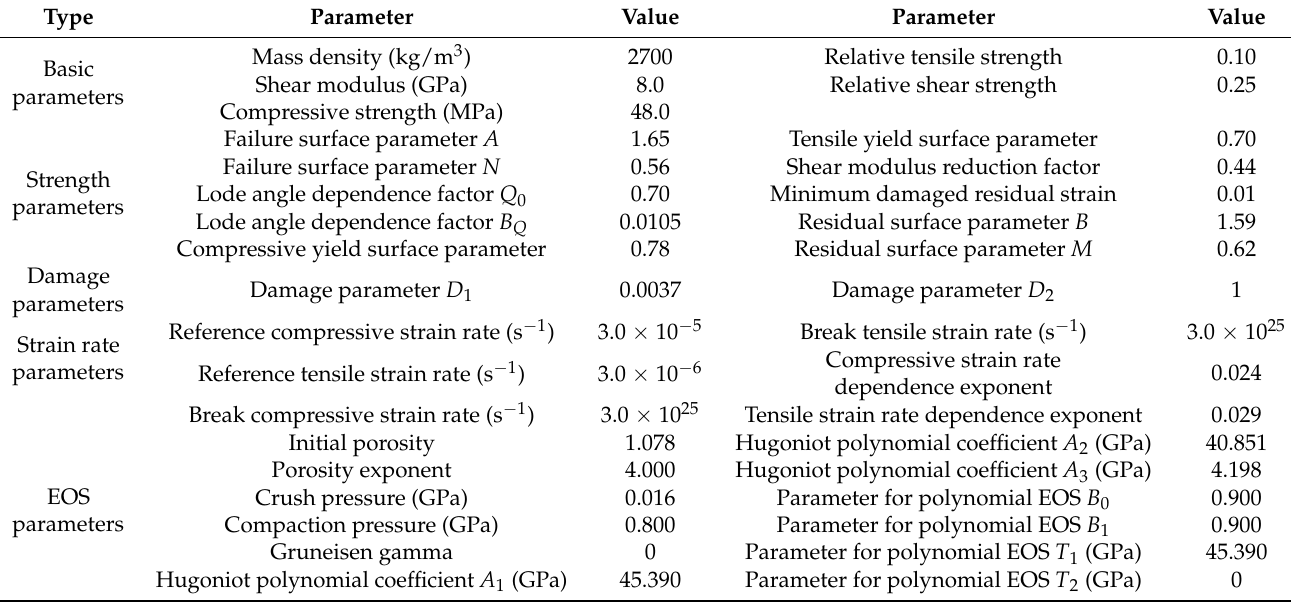
Table 1. RHT model parameters for